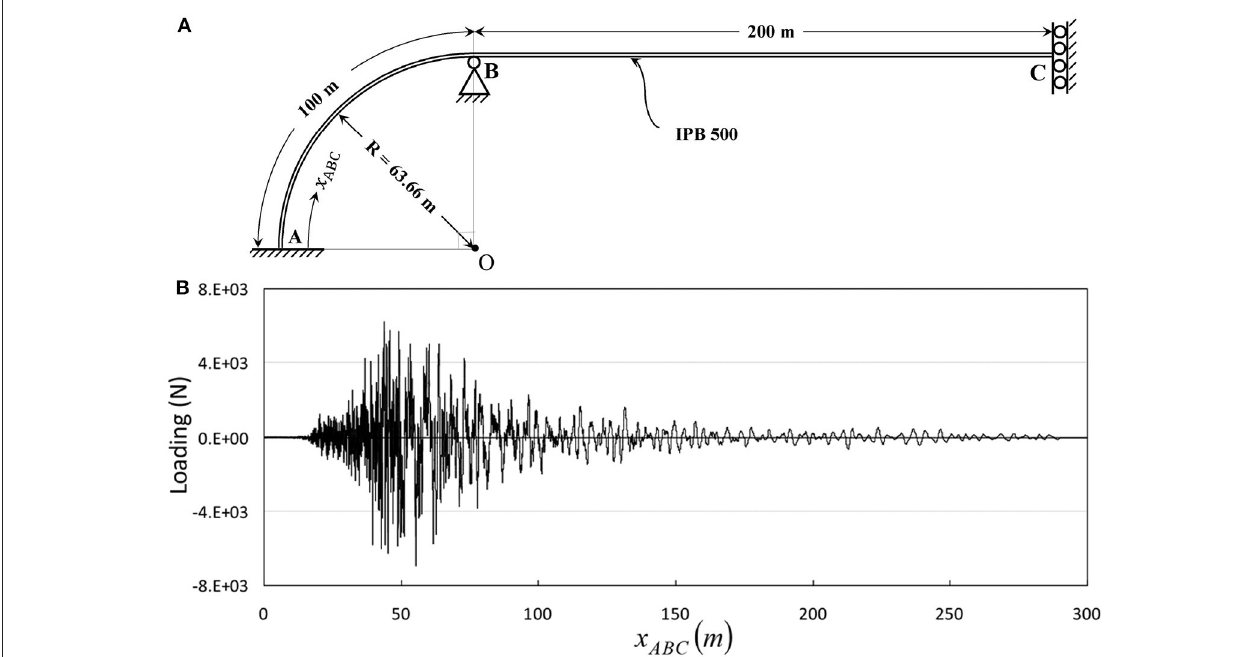
FIGURE 7 | Structural system in the third example (A) structural model and (B) loading.